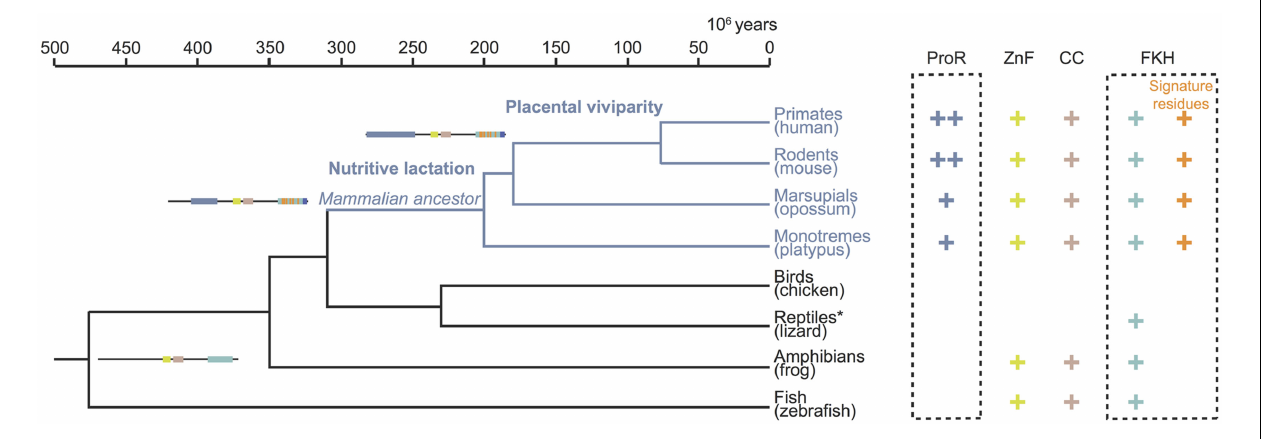
FIGURE 11 | Stepwise gain of functional domains during Foxp3 evolution. The topology and divergence timeline on the phylogenetic tree are adapted from previous studies (Woodburne et al., 2003; Brawand et al., 2008).The presence of a domain in the Foxp3 orthologs is denoted by a plus